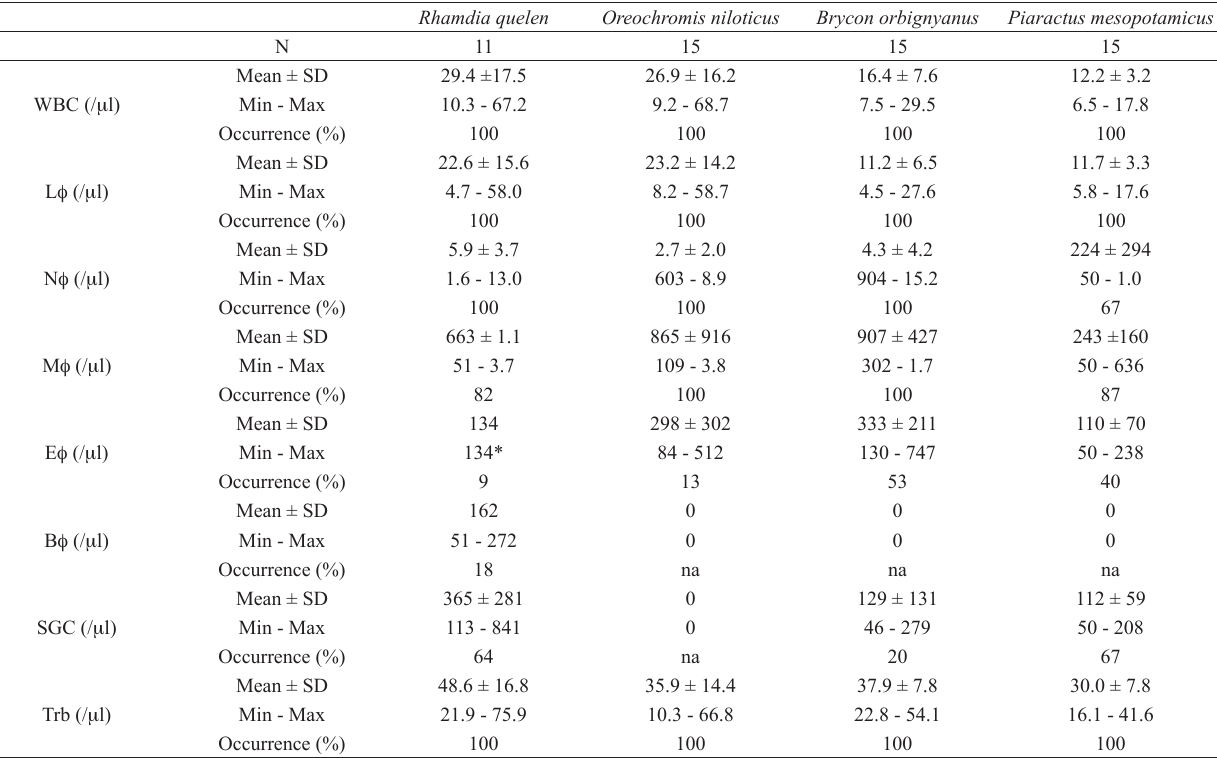
Table 2. Sample number (N), mean ± standard deviation (SD), minimum and maximum and occurrence (%) of white blood cells (WBC; / m l), neutrophils (N f ; / m l), lymphocytes (L f ; / m l), monocytes (M f ; / m l), eosinophils (E f ; / m l), basophils (B f ; / m l), Special Granulocitic Cell (SGC; / m l) and thrombocytes (Trb; / m l) of Rhamdia quelen , Oreochromis niloticus , Brycon orbignyanus and Piaractus mesopotamicus maintained under controlled conditions for a period of 30 days. * E f was found in one individual; na = not applicable.